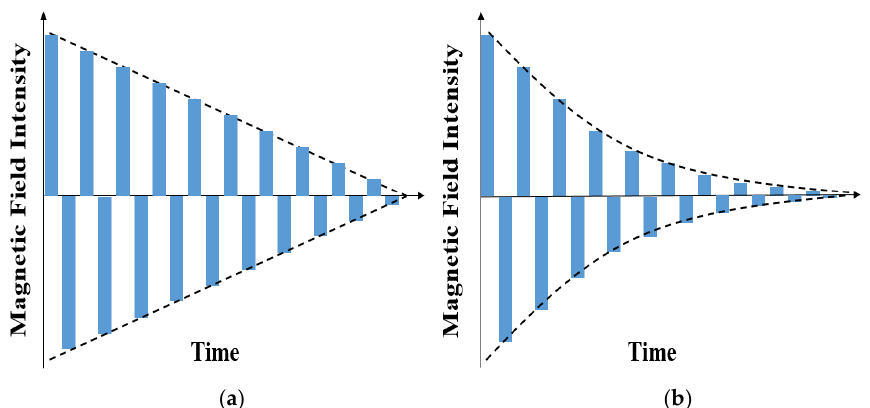
Figure 3. Schematic view of the conventional protocols: ( a ) Anhysteretic Deperm; ( b ) Deperm-ME.